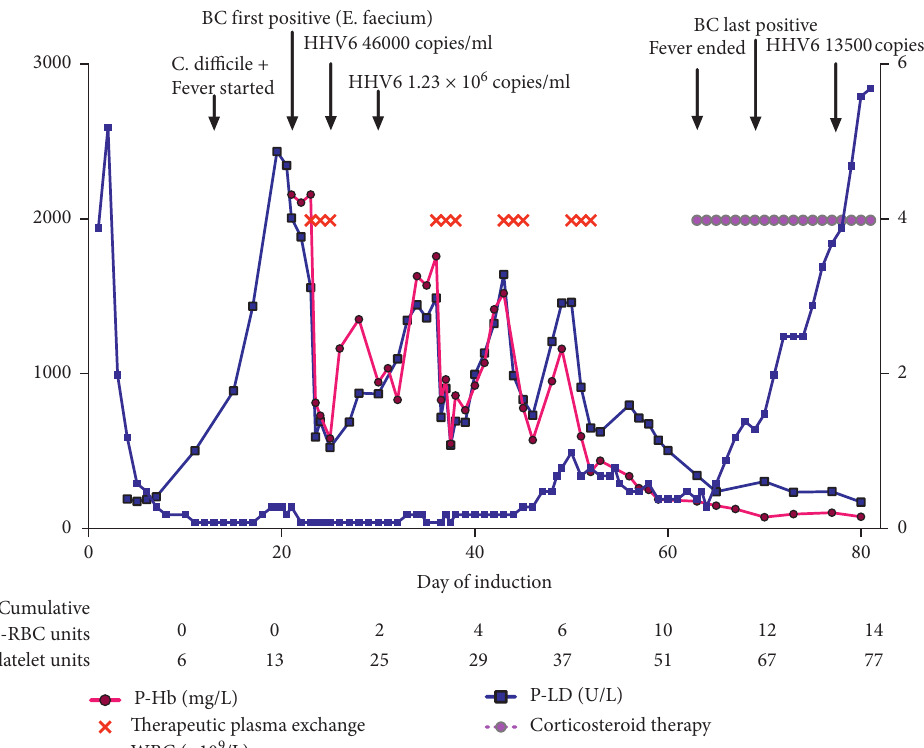
Figure 1: The clinical course of patient 1 (index case). Free plasma hemoglobin (P-Hb) and plasma lactate dehydrogenase (P-LD) are shown on the left y-axis, and white blood cell count (WBC) on the right y -axis. We used metronidazole and fidaxomicin to treat colitis caused by Clostridium difficile and valaciclovir for oral herpes simplex virus (HSV) infection. On day 21, blood culture (BC) was positive as the patient had Enterococcus faecium septicemia which continued the following weeks despite repeated removals and replacements of catheters and use of in vitro-effective antibiotics (tigecycline, linezolid, gentamicin, and daptomycin, which were selected because the patient was allergic to vancomycin). The patient tested positive for human herpes virus 6 nucleic acid test (HHV6-NAT) on day 25 and foscarnet was administered from day 31. Therapeutic plasma exchanges started on day 23 with transient responses to P-Hb and P-LD levels. The first signs of granulopoiesis were seen in bone marrow (BM) aspirate on day 46, and we were able to withhold TPEs after day 52, as the reaction subsided along with recovering hematopoiesis. Cumulative number of blood products transfused is shown below: there was no sign of hemolysis- related increased red blood cell (RBC) consumption, as we transfused the first RBC unit on day Table 2: Patient 1: laboratory findings and cumulative number of transfused blood products at different timepoints. Test